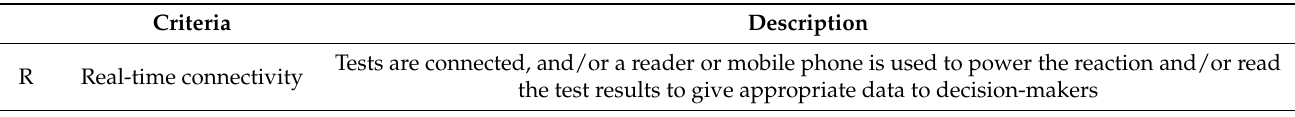
Table 1. REASSURED is the acronym for the criteria under the World Health Organization’s (WHO) current requirements for commercialization of technology to a point-of-care